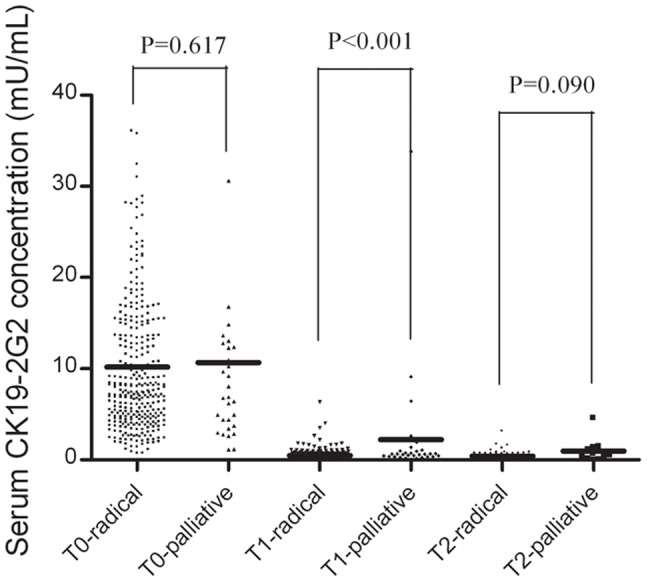
Dynamic changes in serum CK19-2G2 levels in lung cancer patients before and after surgery.The scatter represents a single value and the lines represent the mean levels of CK19-2G2 in lung cancer patients who received radical or palliative operations.